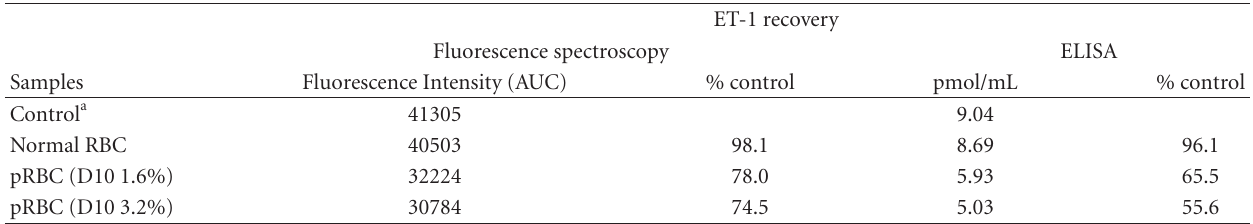
Table 1: Absorption of ET-1 by pRBC (D10 strain) or haemozoin: comparison between fluorimetric detection and ELISA assay.